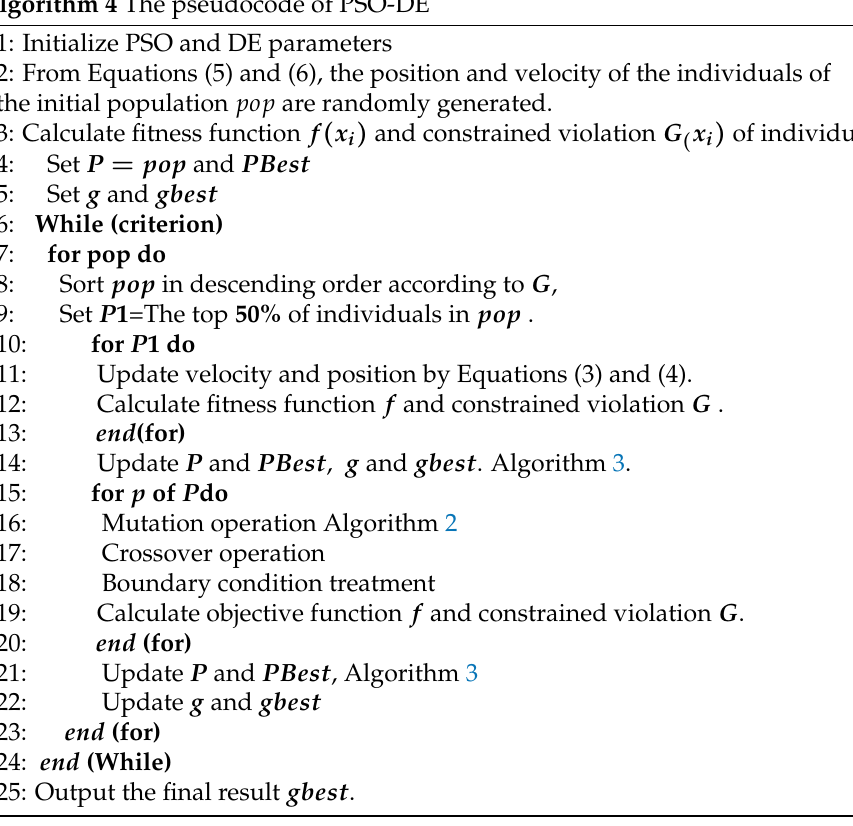
Algorithm 4 The pseudocode of